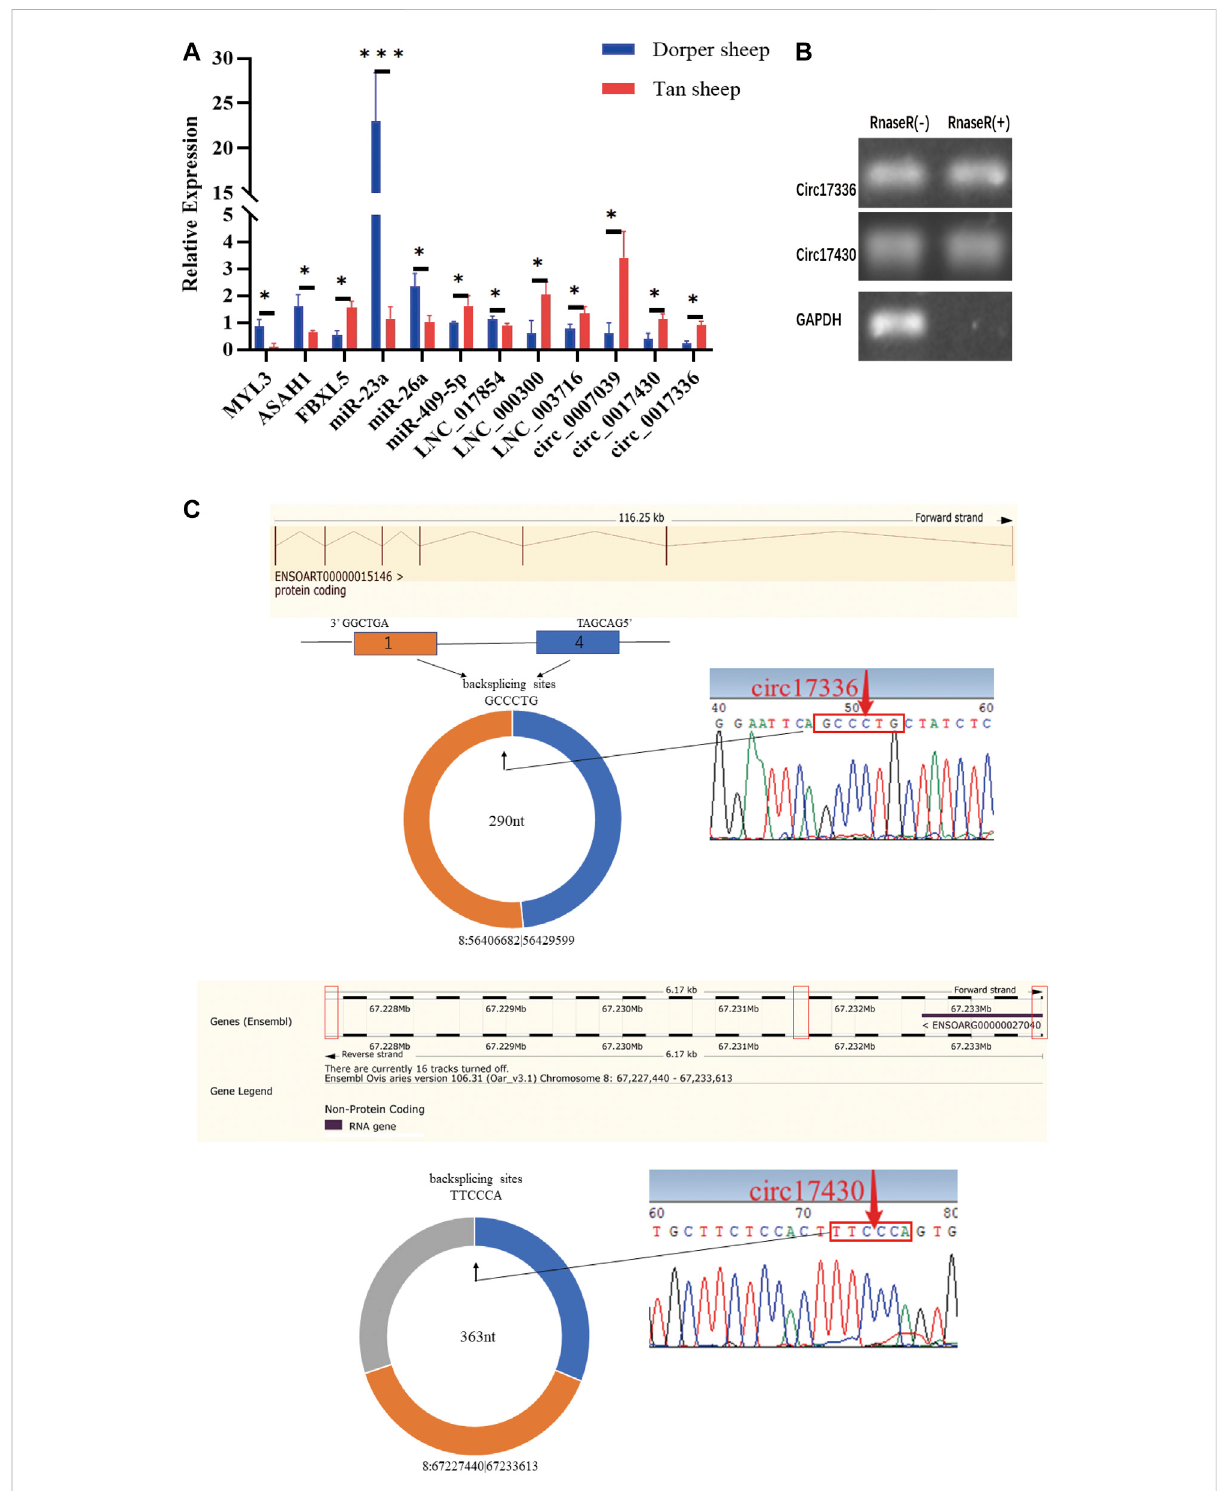
FIGURE 6 (A) The expression levels of mRNA, miRNA, IncRNA and circRNA were veri fi ed by qPCR. (B) The results obtained from use of Rnase R indicate thattheexpressionlevelsofcirc_0017336 andcirc_0017430areresistant toRnaseR. “ RnaseR(+) ” indicatesRNAtreatedwithRNaseR: “ RnaseR( − ) ” indicates untreated RNA. (C) The backsplice junctions of circ_0017336 and circ_0017430 were veri fi ed with Sanger sequencing. The red arrows indicate head-to-tail back-splicing sites of